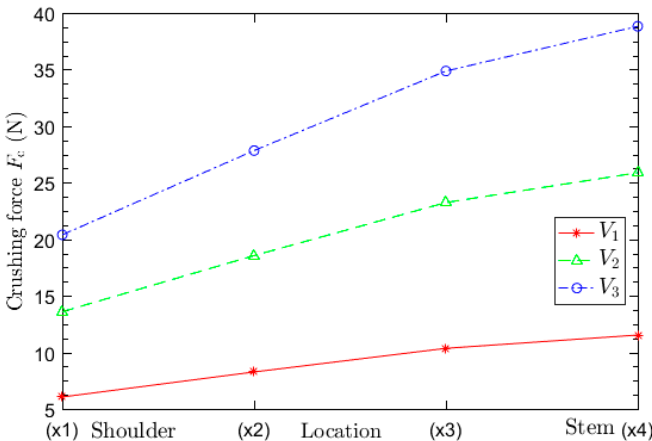
Figure 18. Crushing force in relation to collision location at different speeds.